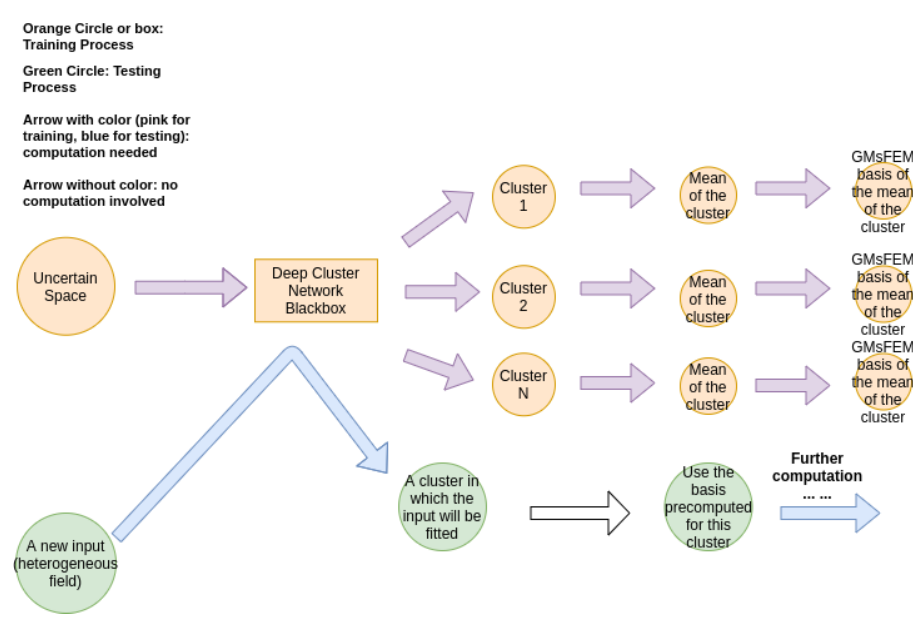
Figure 3. Work flow of the proposed method.